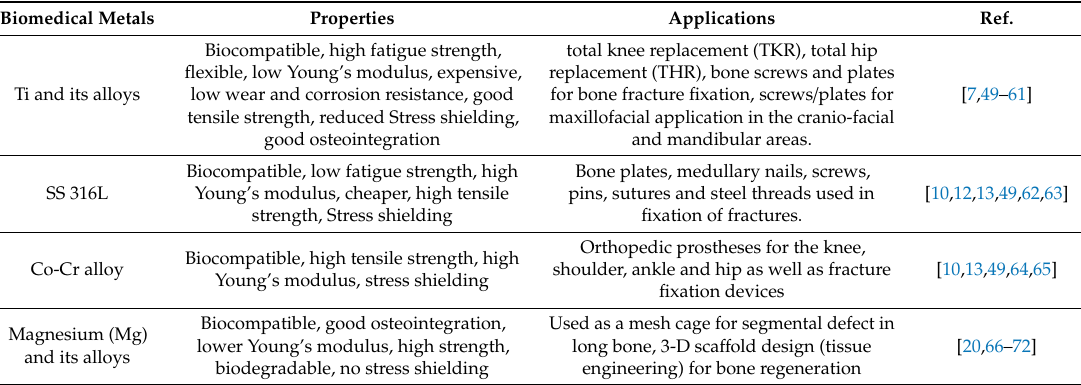
Table 1. Biomedical metals, properties, manufactured bioimplants, and their